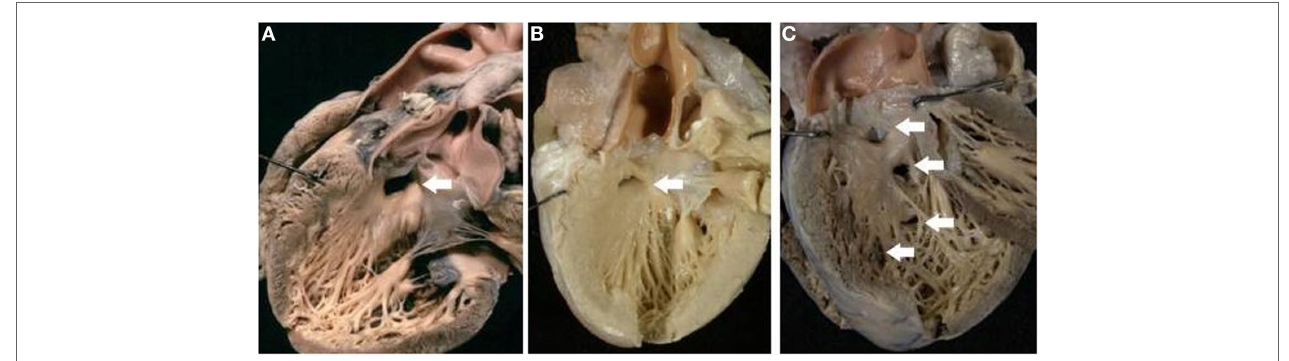
FigUre 4 | complete Tga with VsD . (a) Perimembranous defect: the posteroinferior rim of the defect is fibrous. (B) Muscular defect: all the borders of the defect are muscular. (c) Multiple defects: a perimembranous defect and three muscular trabecular defects are